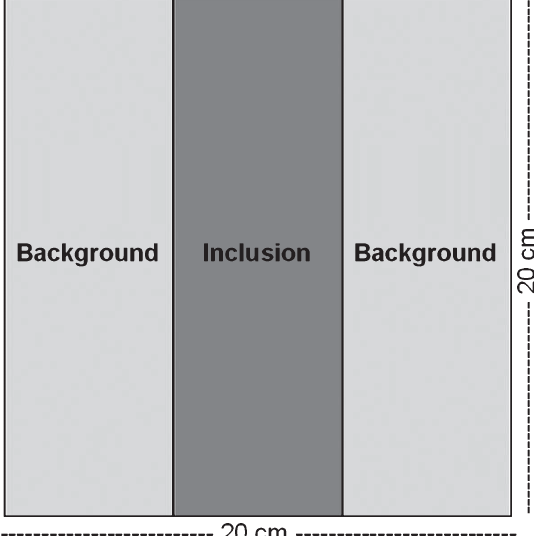
Fig. 13. The protocol of the psychophysical test performed in this work foresees that the user is asked to identify two region of the virtual model, one stiffer (the inclusion) and one softer (the background). The model was implemented using the plain strain approximation, and the model dimension was 20cm by 20cm.